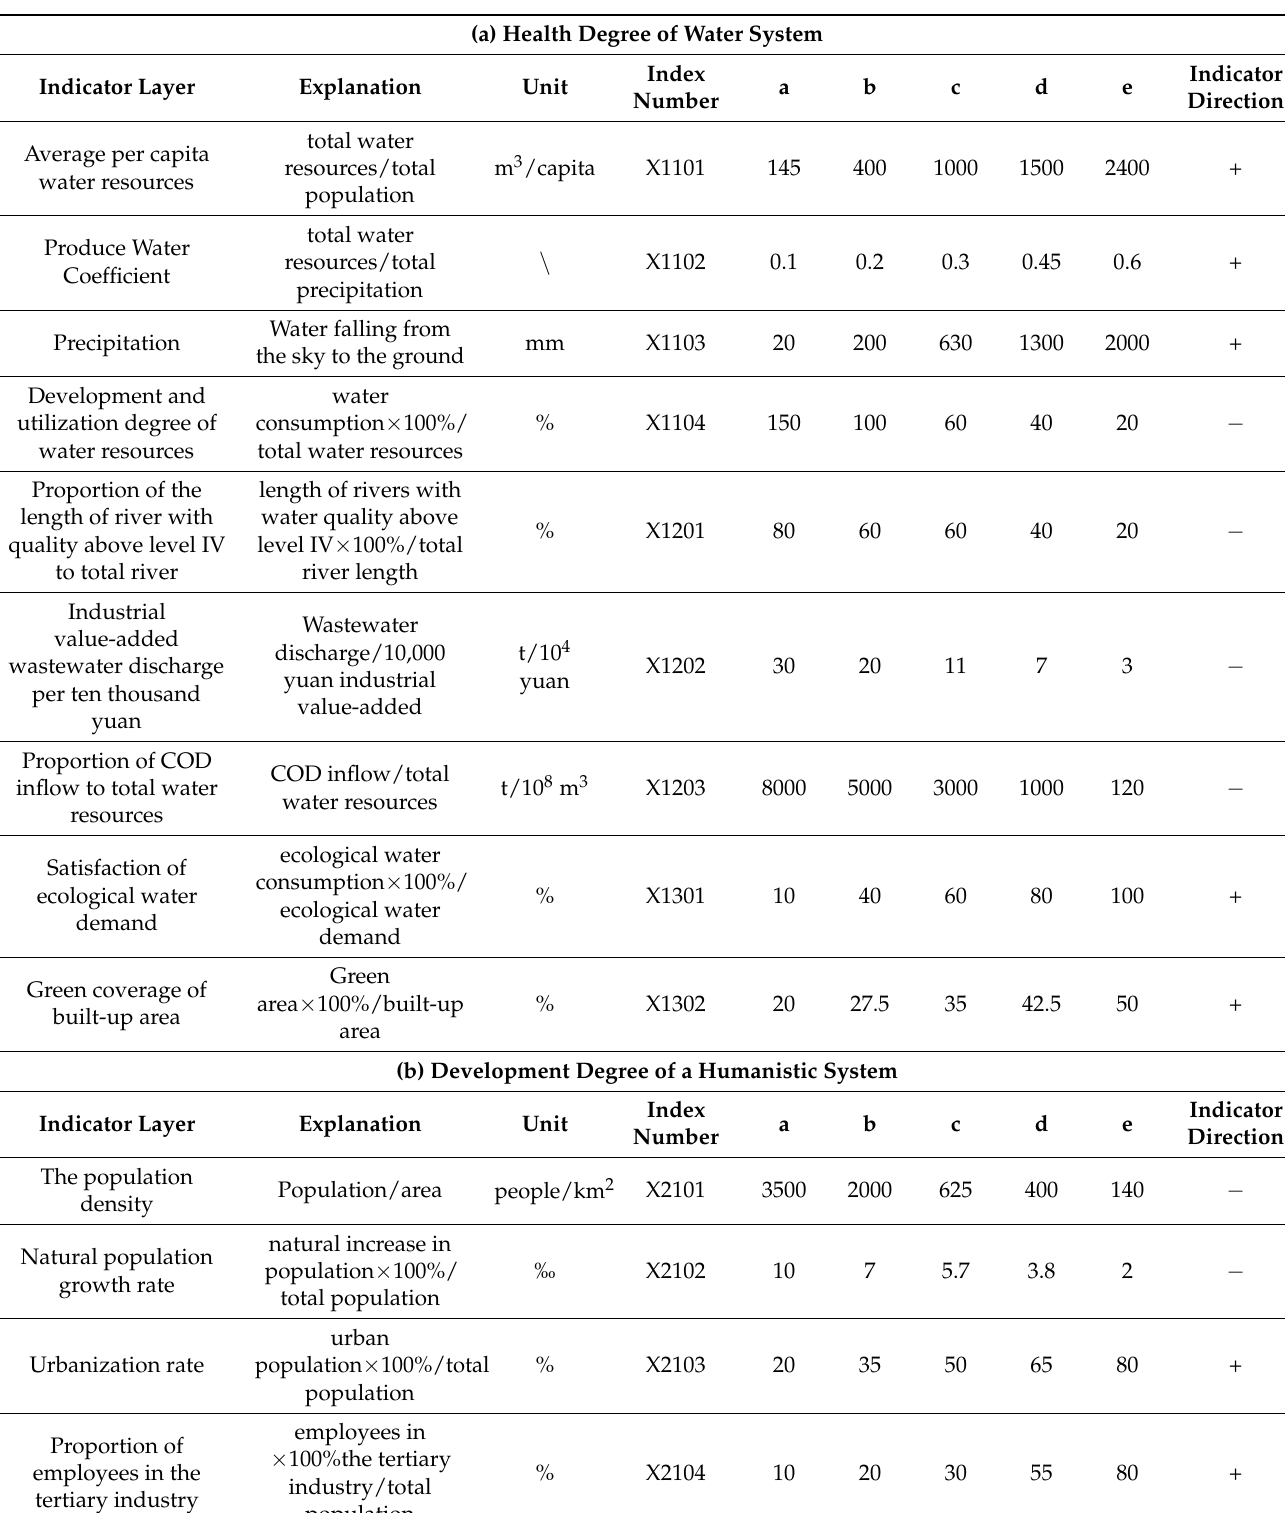
Table 1. Index system for the harmonious assessment of the human–water relationship